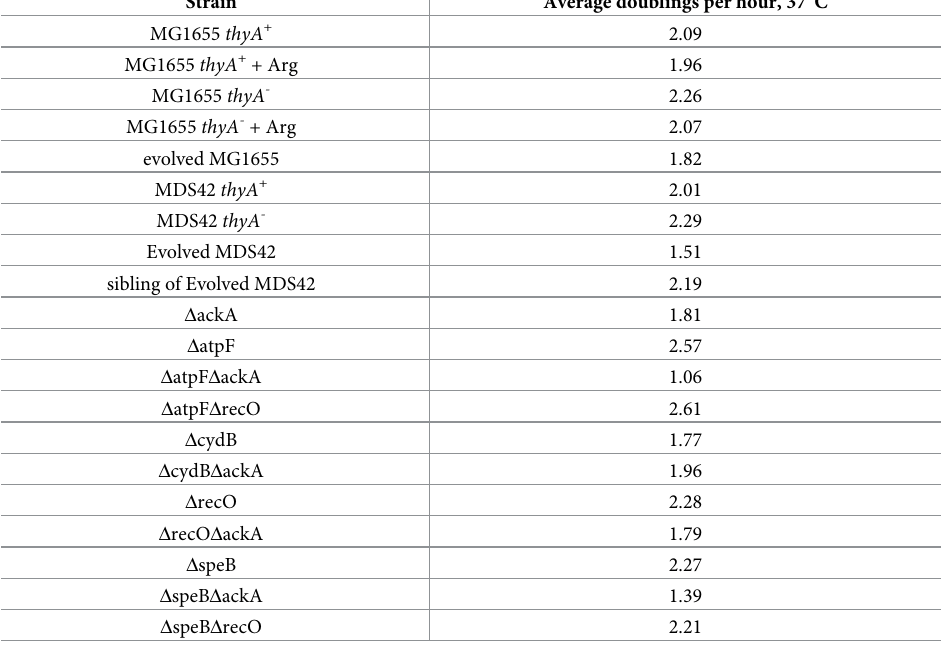
(S1H Fig and Table 3). speB encodes agmatinase, a putrescine biosynthesis enzyme. Putrescine has many diverse functions in the cell, including a role in pH homeostasis [31,32]. Its metabo- lism is intricately linked to that of glutamate and arginine. Together these interlinked processes comprise three of the cell’s amino-acid-dependent decarboxylase acid resistance systems, which play critical roles in deacidification in E . coli [33]. When a speB deletion was transferred to the thyA - MG1655 strain, it showed significant enhanced survival compared to its parent (Fig 2E). Furthermore, a Δ speB mutant combined with Δ recO shows significantly enhanced survival compared to either strain in isolation (Fig 2E). Table 4. Growth rates of strains in rich defined